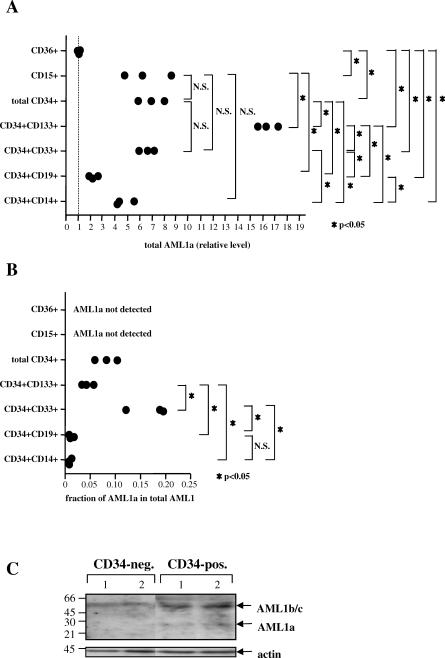
Expression of AML1 Isoforms in Human Hematopoietic CompartmentsHuman blood cells from three pooled individual umbilical cord samples were sorted on the basis of the cell surface molecules indicated, and the levels of transcripts corresponding to different AML1 isoforms were quantitated in triplicate and normalized relative to G6PD.(A) Total AML1 transcript levels are presented as relative levels of that observed in CD36+ cells.(B) The fraction of AML1a relative to total AML1 transcripts was determined. In (A) and (B) Kruskal-Wallis test showed statistical significance of difference among the fractions (p < 0.01). Mann-Whitney tests were then used to estimate the difference of any given two fractions, with asterisks indicating the statistical significance (p < 0.05). N.S., not significant.(C) Western blot analysis of AML-isoform expression using the anti-RHD antibody in CD34+ and CD34− fractions of human cord blood (4 × 105 cells each) from two individual healthy donors. Analysis of actin expression in the same samples provide a control for loading.